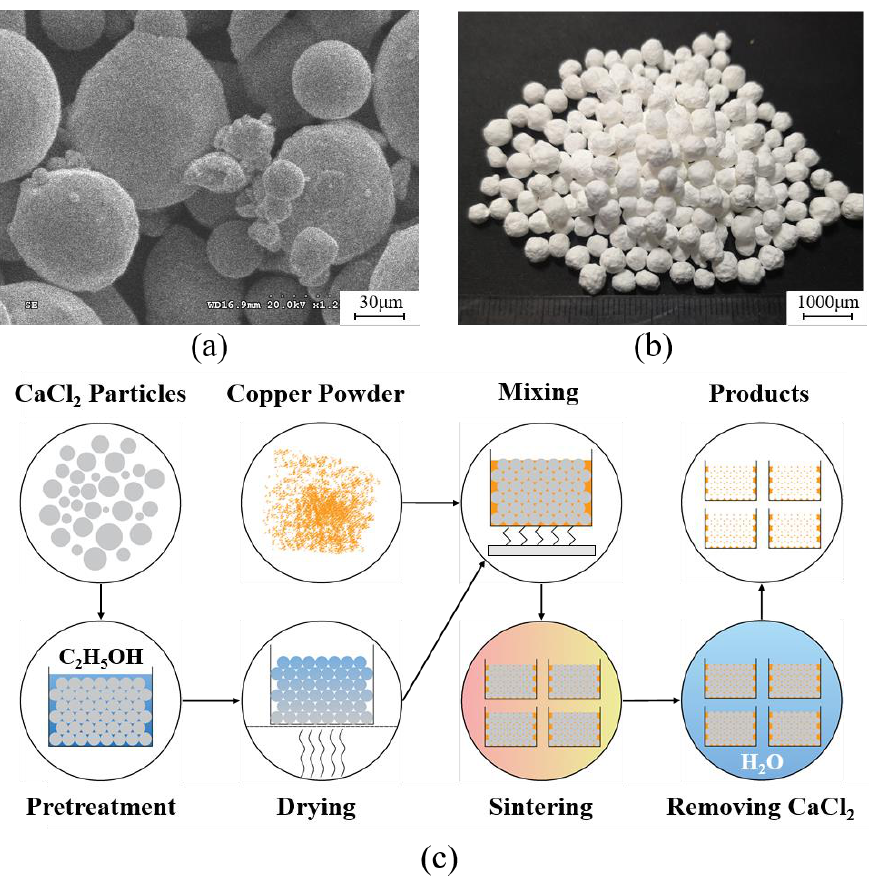
Figure 1. ( a ) SEM photos of copper powder. ( b ) Anhydrous CaCl 2 particles for preparing OCCF. ( c ) Schematic of modified pressureless sintering–dissolution process.